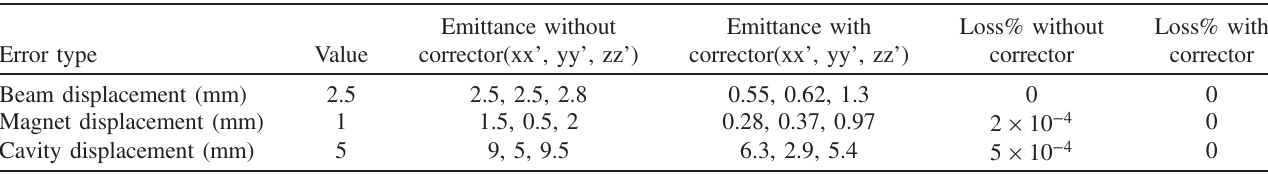
TABLE XIII. Emittance growth and beam loss as a function of displacement errors with and without correctors averaged over 10 3